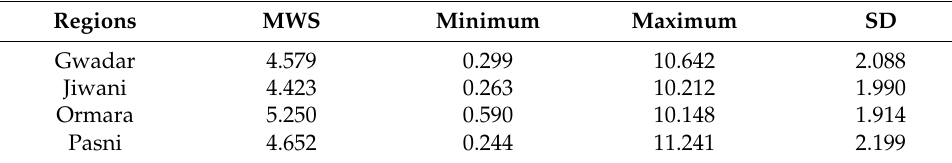
Table 2. WS (m/s) statistics of all